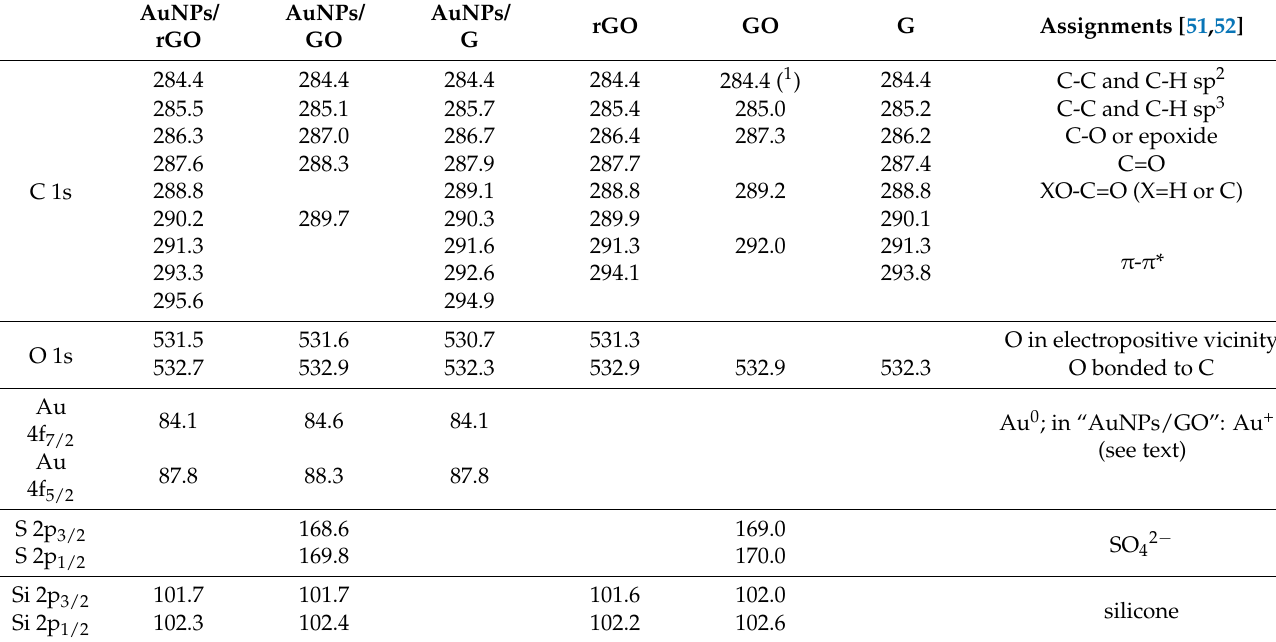
Table 3. Corrected BE ± 0.1 eV and corresponding